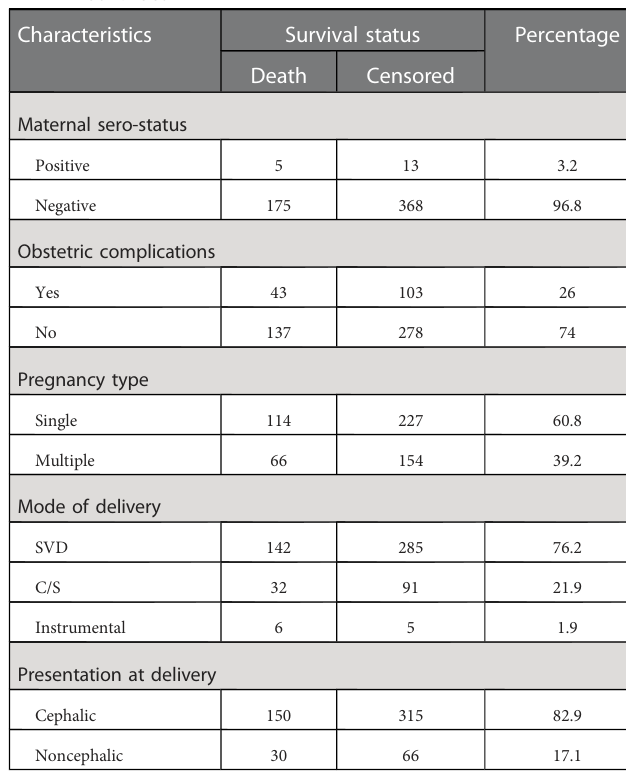
SVD, spontaneous vaginal delivery; C/s, caesarian